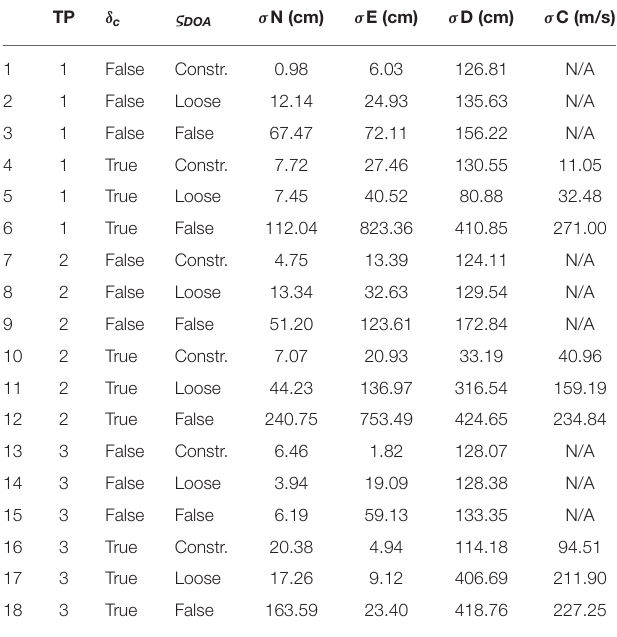
TABLE 4 | Standard deviations of the North, East, Depth, and Sound-speed components, for each parameterizations ( δ c and ς DOA columns) and each transponders (TP column) in static modes.